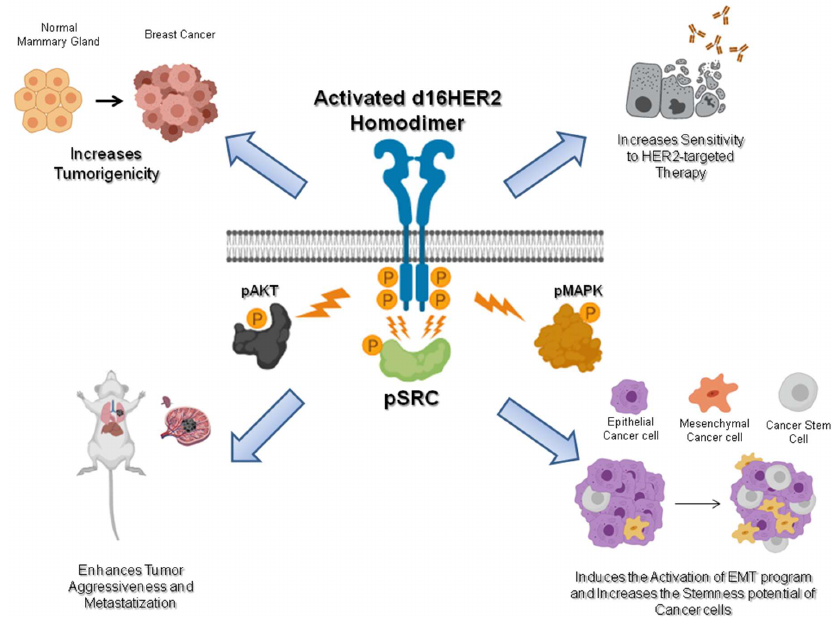
Figure 2. Schematic of the pathobiological features of d16HER2. The homodimerization of the d16HER2 splice isoform results in autophosphorylation of the tyrosine kinase domains and induction of downstream signaling. Cell signaling downstream of d16HER2 is transduced to the nucleus through different circuitries including Mitogen-Activated Protein Kinase ( MAPK), Protein Kinase B (AKT), and mainly by Proto-oncogene tyrosine-protein kinase Src (SRC). Through the activation of these downstream pathways, d16HER2 is able to increase tumorigenicity and sensitivity to anti-HER2 drugs and enhance tumor aggressiveness and metastatization. d16HER2 also induces activation of the epithelial–mesenchymal transition (EMT) program and the enrichment of cancer stem cells (CSCs) inside the tumor. Created byBiorender.com.